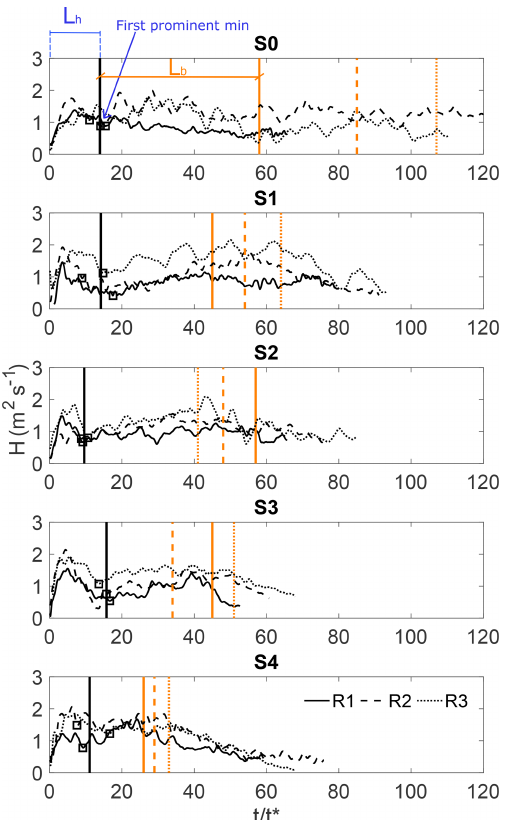
Figure 3. Determination of the gravity current head extension from the first prominent minimum of the function H ( L h ). The extension of the body ( L b ), as identified by the cumulative sum of the depth- averaged streamwise velocity, is also traced with the red vertical